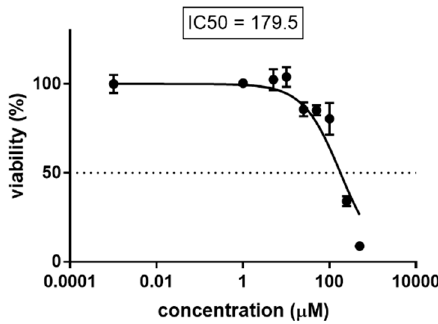
Figure 7. Cytotoxic effect of different incubation concentrations of compound 9b on HepG2 cells.